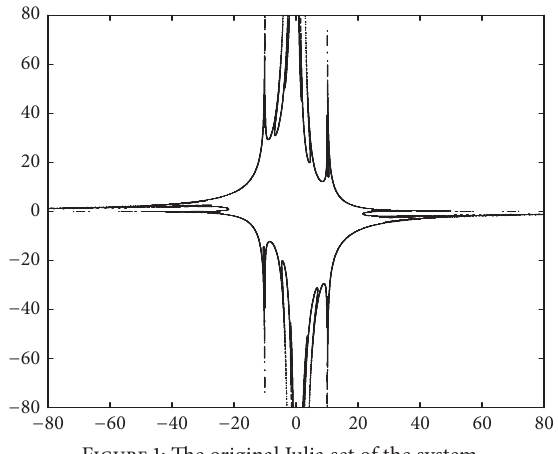
Figure 1: The original Julia set of the